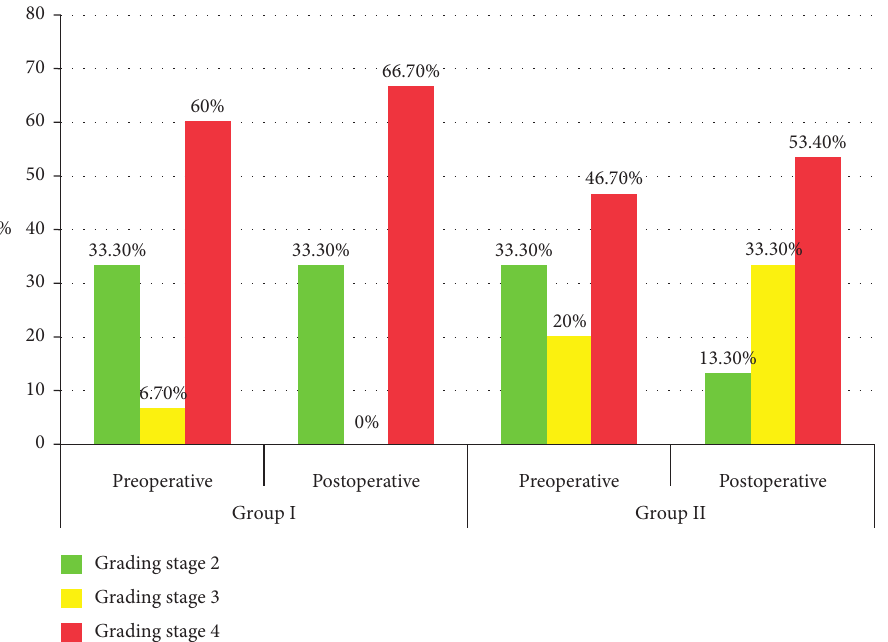
Figure 7: Comparison between the two groups with respect to the postoperative visual